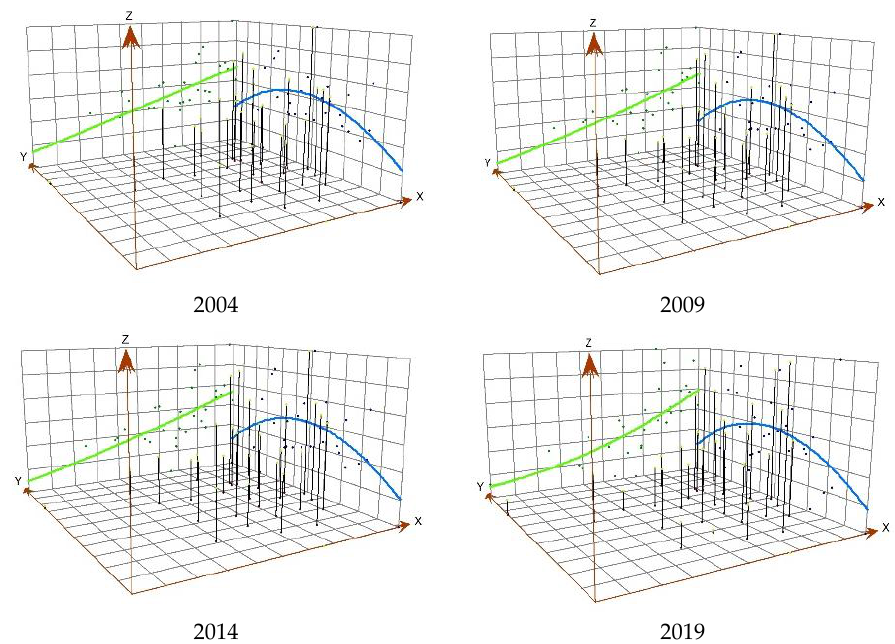
Figure 4. Trend analysis of the co-agglomeration index of 30 provinces.